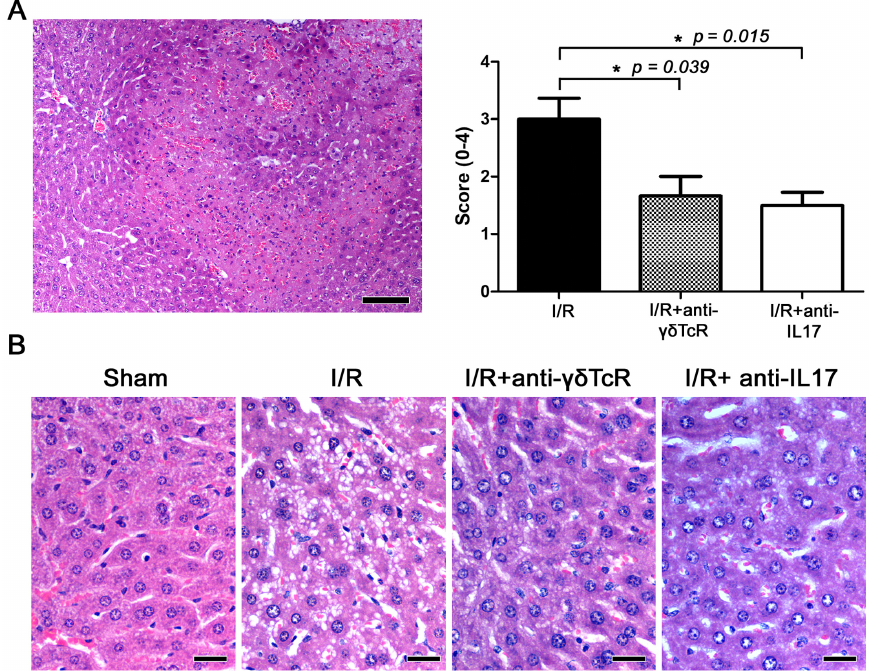
Figure 1. Depletion of γδ TcR cells or IL17a ameliorates I/R-induced liver injury in mice. ( A ) Representative area with bridging submassive coagulative necrosis area in mouse liver after I/R. The necrotic area of liver tissue shows pale eosinophilic stain, hepatocyte loss, hyperhaemia and multifocal haemorrhages and typical cell nuclear changes in necrosis. Histopathological scores of I/R injuries given to the different experimental groups are shown in the bar graph on the right. Pretreatments significantly ameliorated liver histopathology. ( B ) Side-by-side comparison of typical hepatocyte histology in the four experimental groups of mice. Compare normal hepatocytes of sham-operated controls with hepatocytes showing cytoplasmic vacuolar degeneration in the I/R-treated mice. Degenerative lesions are milder after the neutralization of γδ TcR cells or IL17a. ( A ) and ( B ) Haematoxylin and Eosin. Scale bars: 100 μ m ( A ) and 25 μ m ( B ). ( A ) Numbers on the Y-axis of the bar graph correspond to the mean ± SEM of the histopathological score; * p < 0.05.